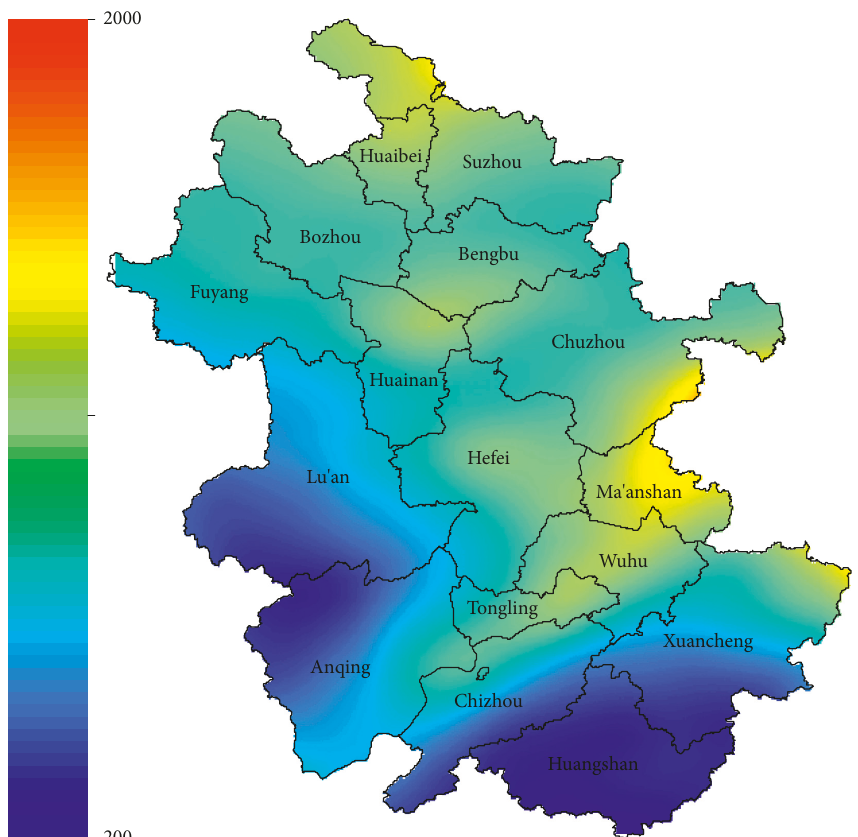
13 molec./cm 2 ) from 2005 to 2016 in Anhui 2 columns ( × 10